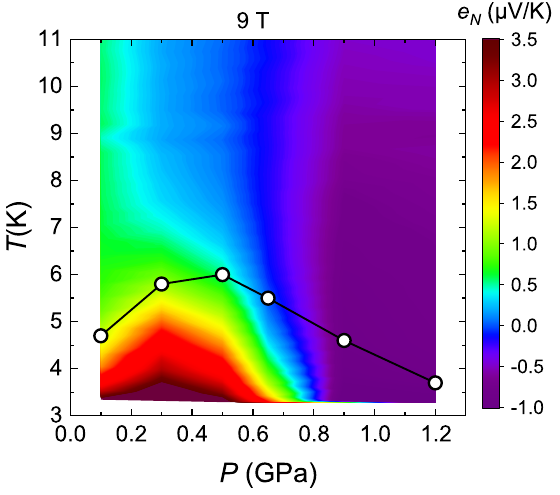
FIG. 8. Temperature-pressure profile of the Nernst signal e N . The contour plot of the Nernst signal e N at a field of 9 T is shown in the temperature-pressure plane. The white circles indicate the zero-field T c